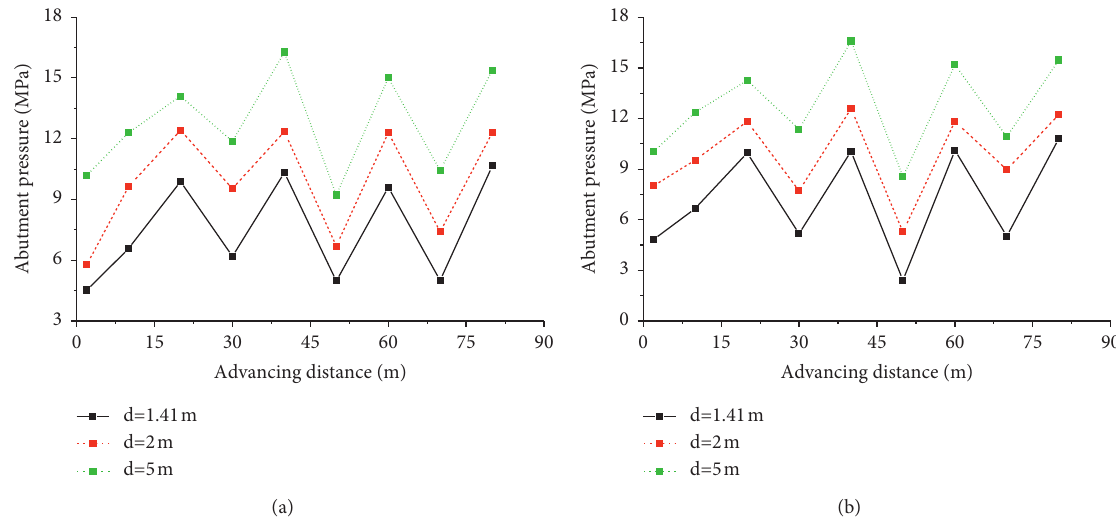
Figure 18: Abutment pressure distribution in the limit equilibrium area with different joint spacings. (a) Dip angle of joint of 45 ° . (b) Dip angle of joint of 135 °